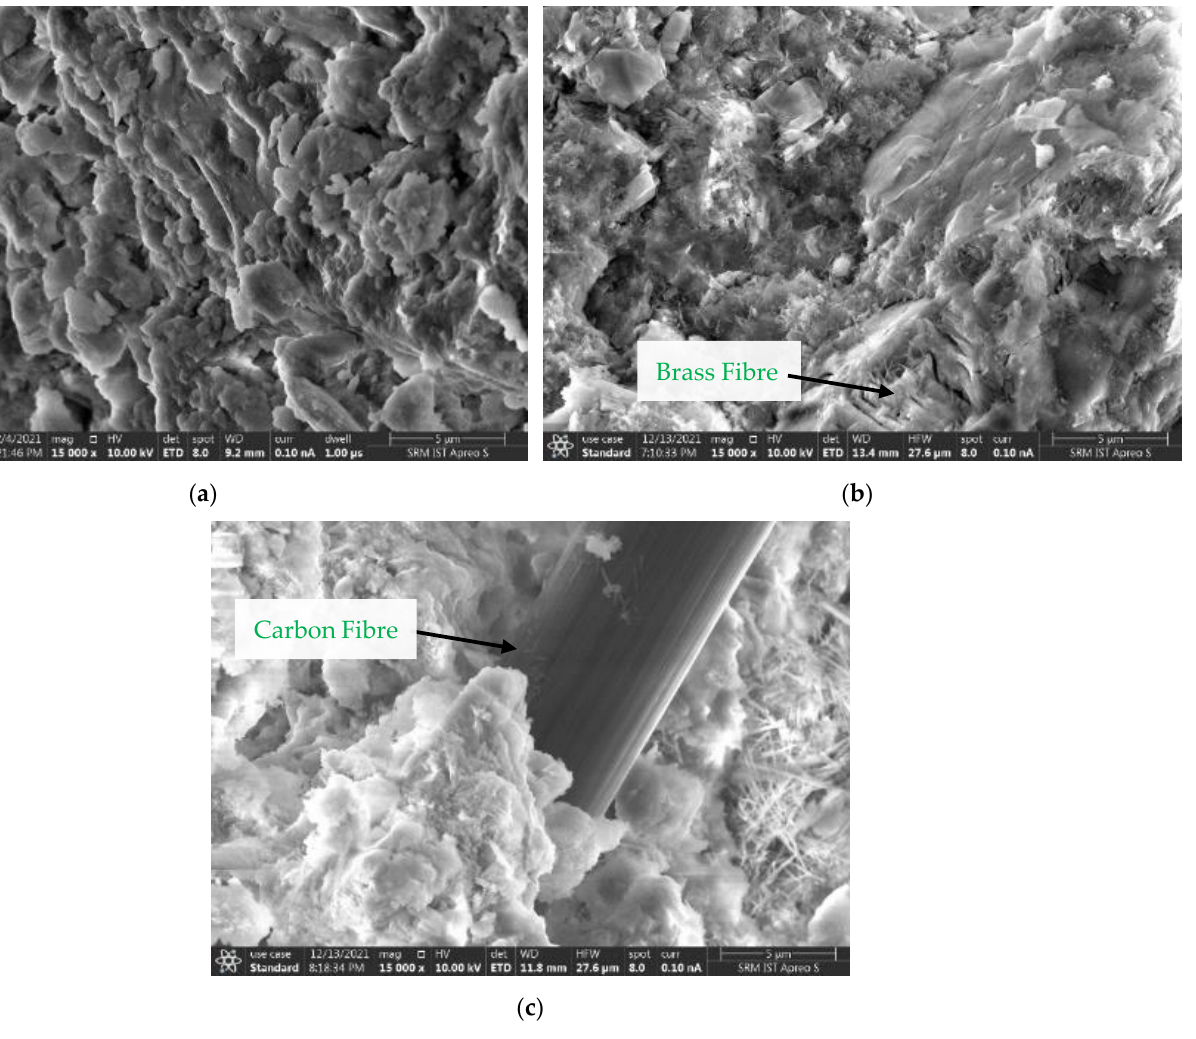
Figure 19. SEM images of the cement mortar. ( a ) Conventional mortar; ( b ) Brass fibre added mortar; ( c ) Brass – carbon hybrid fibres added mortar.